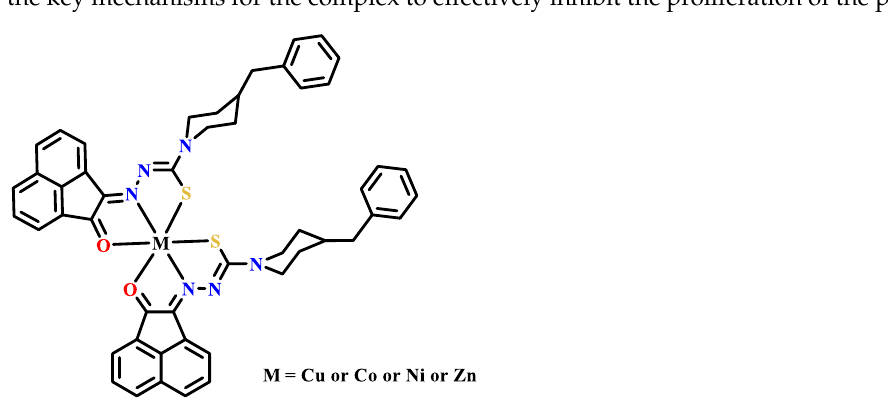
Figure 16. The four Co(II)/Ni(II)/Cu(II)/Zn(II) complexes based on 1-acenaphthenone hydrazone ligand with 3-(4-benzylpiperidyl) thiourea side chain.